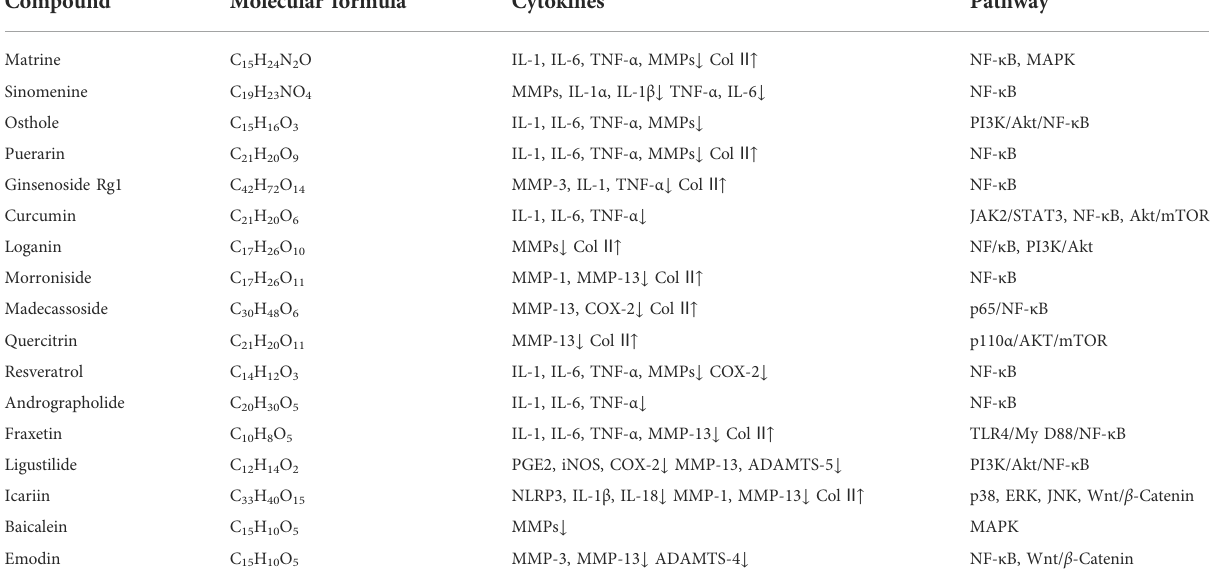
TABLE 3 The therapeutic in fl uence of natural products in OA.